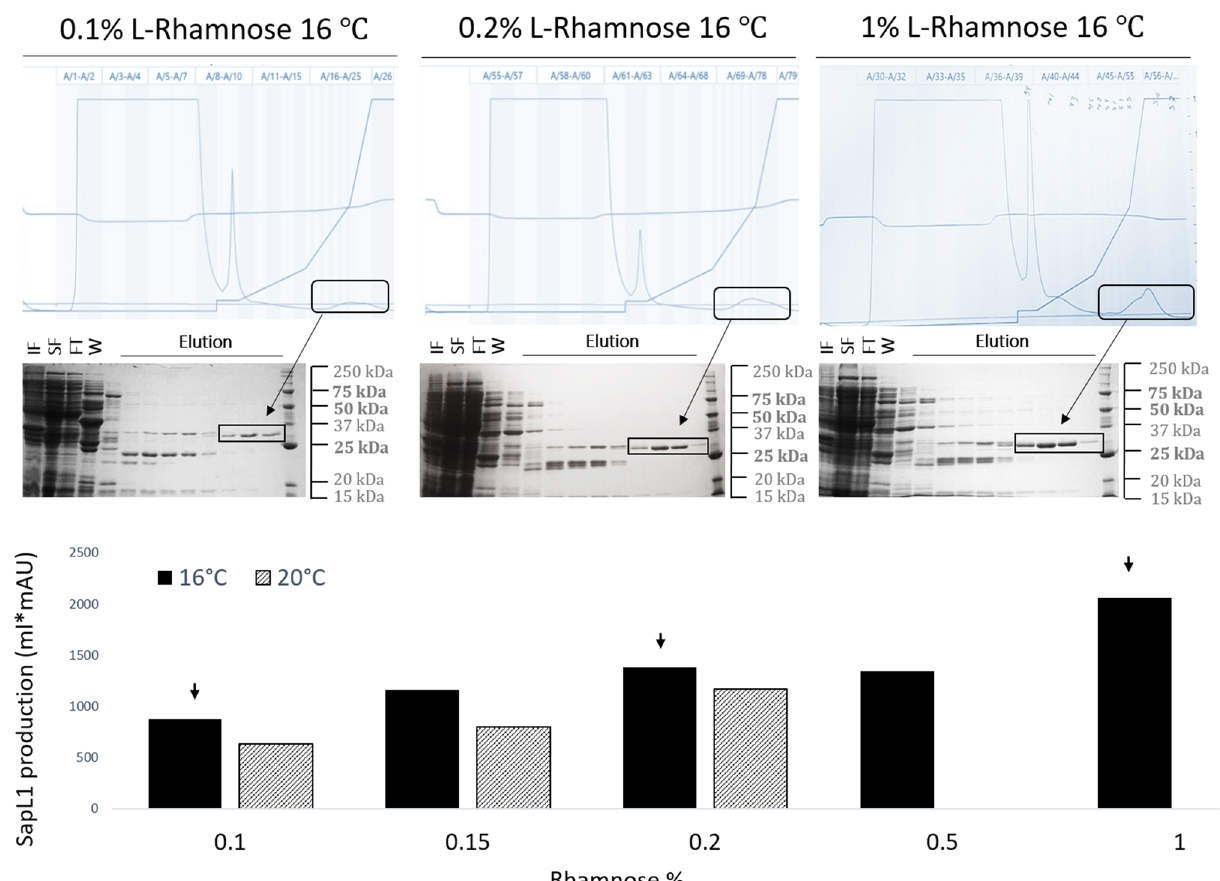
Figure 2. Rhamnose influence on SapL1 solubility. ( A ) SapL1 purification chromatograms at 0.1%, 0.2%, and 1% rhamnose with their corresponding SDS-PAGE profile. IF: Insoluble fraction, SF: Soluble fraction, FT: Flow through, W: wash and elution, from left to right respectively. Black rectangles indicate the elution peaks and elution fractions containing SapL1 on SDS–polyacrylamide gels. ( B ) Numerical values derived from the integration of areas under the peaks corresponding to SapL1 for each experiment. Black and striped bars represent the results for experiments performed at 16 °C and 20 °C,